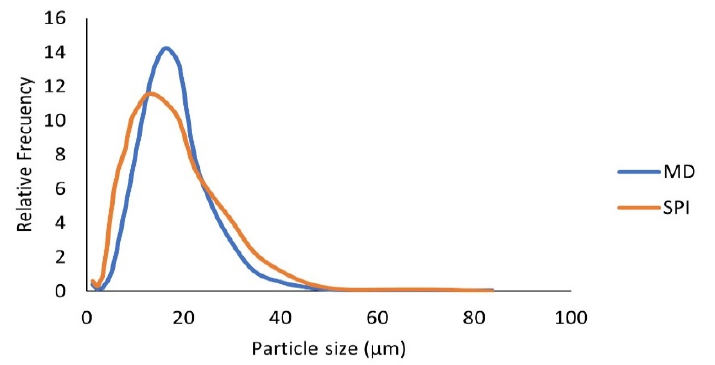
Figure 2. Particle size distribution in muicle extract microcapsules obtained under optimal drying conditions (160–80 °C, 10% wall material concentration for MD and 180–70 °C, 5% wall material for the SPI).